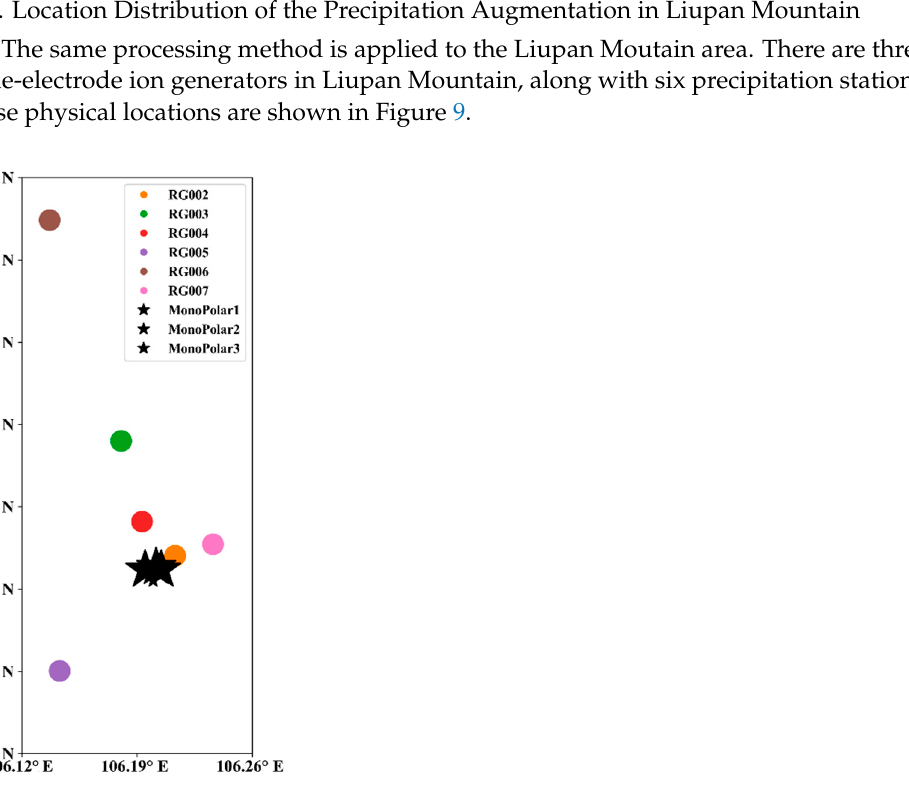
Figure 9. Location map of precipitation gauge stations and experimental device in Liupan Mountain.